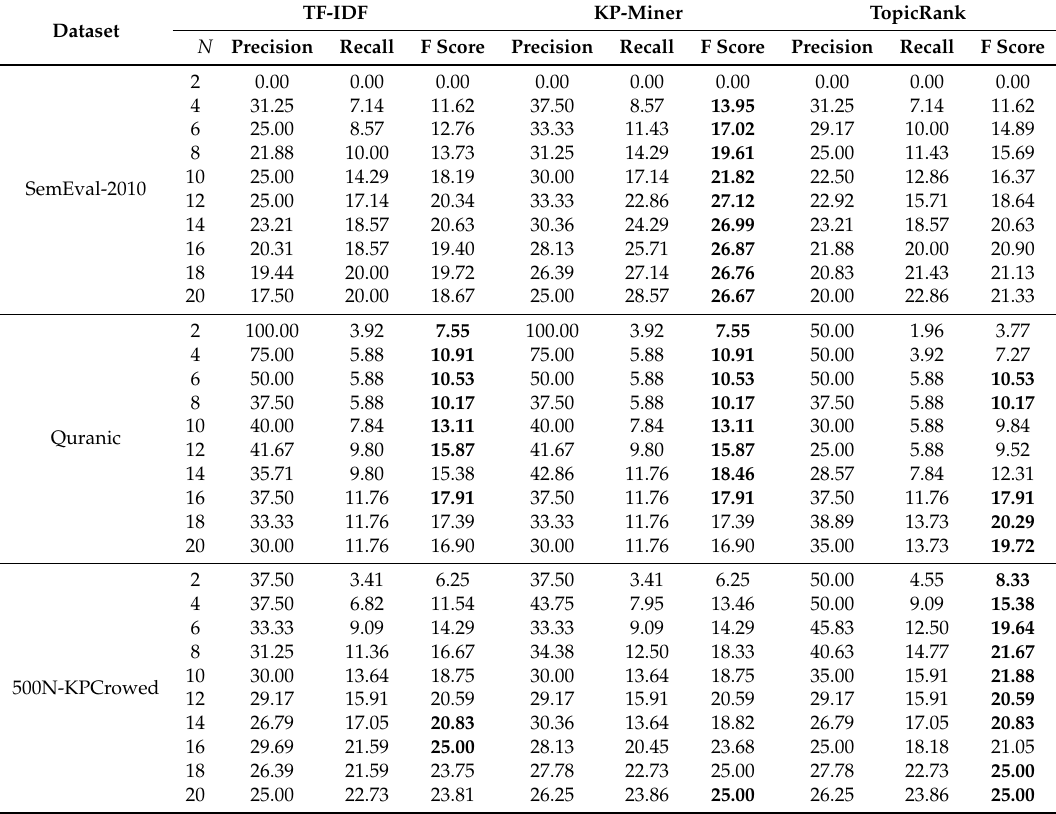
Table 4. Performance of the selected algorithms at chosen cut-off